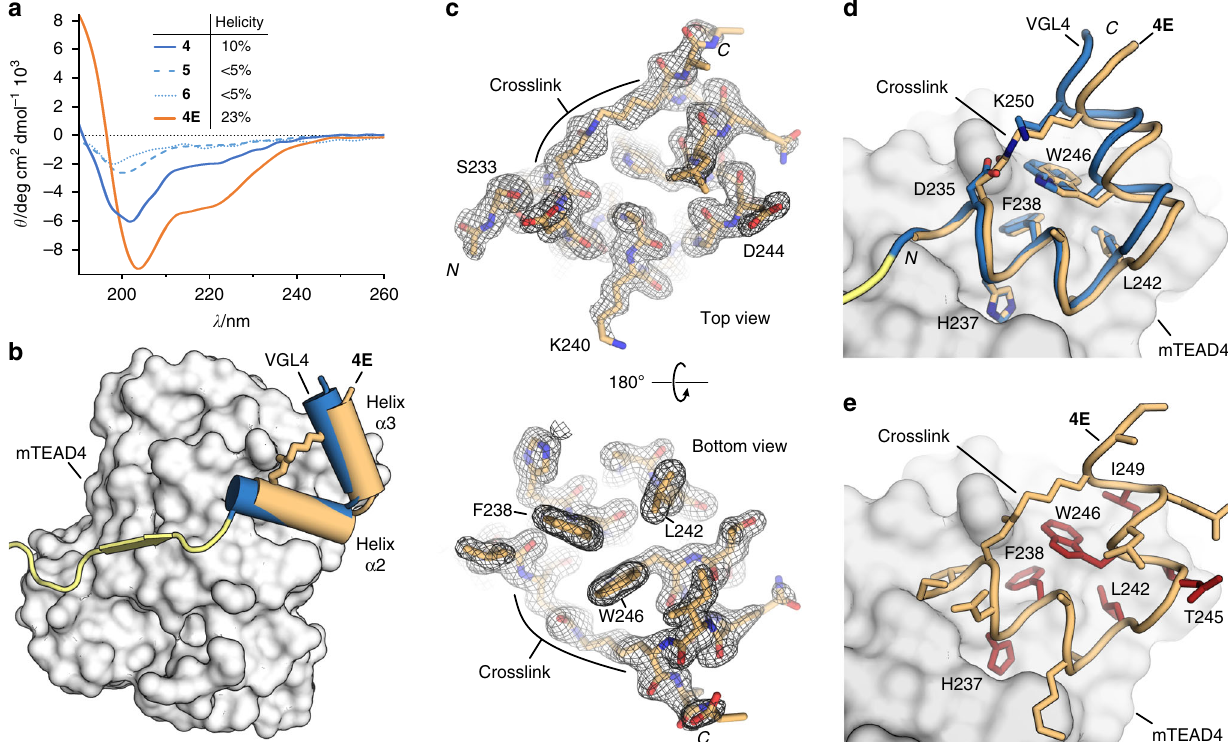
Fig. 2 Structural characterization of the stabilized two-helix motif was performed. a CD spectra of selected peptides and calculated helicities are shown (for details, see Methods section). Source data are provided as a Source Data fi le 42 . b X-ray crystal structure of 4E (orange) co-crystallized with mTEAD4 (grey, PDB: 6SBA) superimposed with the corresponding part of the TEAD-binding motif of VGL4 (blue/yellow, PDB: 4LN0). c 2Fo-Fc electron density map (black, contoured at σ = 1.2) of 4E (PDB: 6SBA) from top and bottom view. d Superimposition of two-helix motif from VGL4 (blue, PDB 4LN0) and peptide 4E (orange, PDB: 6SBA), side chains of residues previously identi fi ed as interacting with TEAD are shown explicitly. e Structure of 4E in complex with mTEAD4 (PDB: 6SBA) including all side chains is shown. Hotspot amino acids are highlighted (red) as determined by experimental alanine-scanning using SPR (mTEAD4) as readout. Crystal structure of the E4 /mTEAD4 complex is available under PDB: